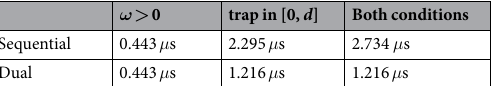
Table 2. Minimal final times for the launching + expansion process with limited frequency or/and trap center, see text. Parameters: =